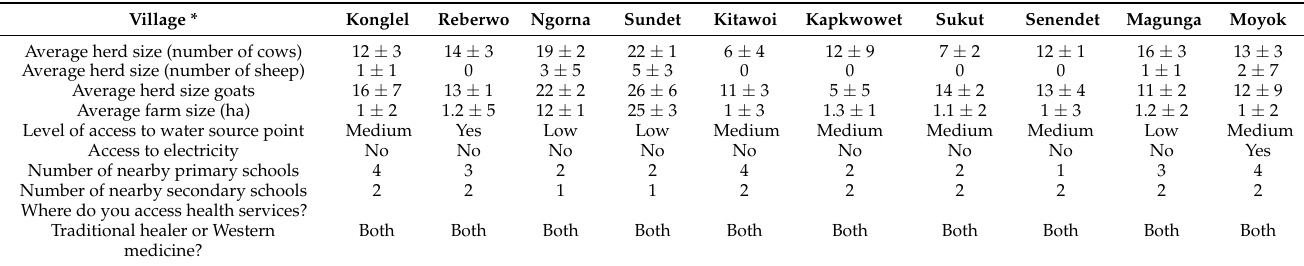
Table 1. Sociodemographic